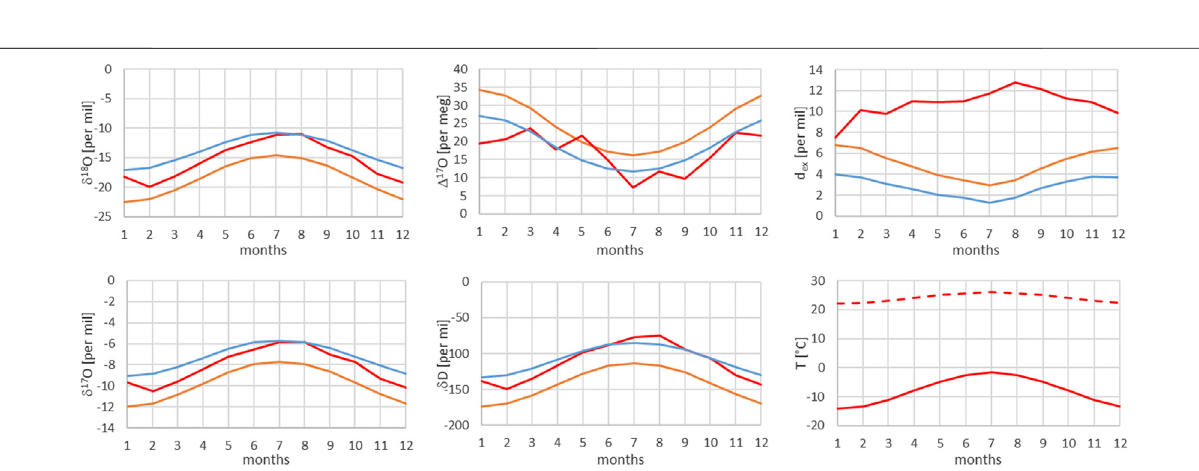
Frontiers in Earth Science |